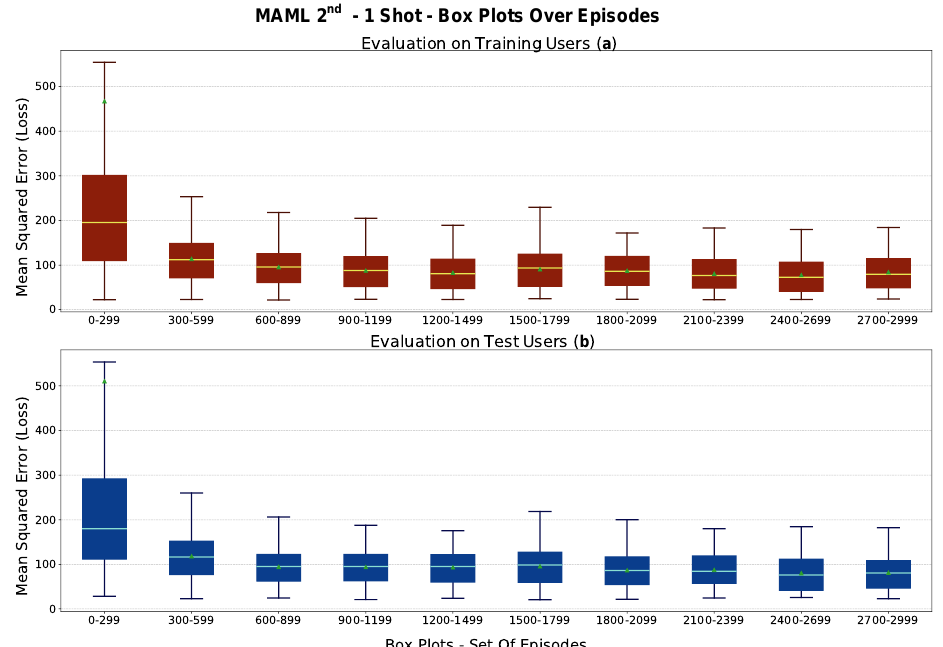
Figure 14. MAML 2 nd 1–shot experiment, Box Plots. Learning trends of Meta-L, box plots versus episodes (evaluation loop) for the Breath Meta-Dataset . The box in ( a ) depicts the trend for users in the training set ( T r tasks). In ( b ), the trend for the users of the test set ( T v tasks)is shown. The box’s mid-line represents the median value, while the little green triangle represents the